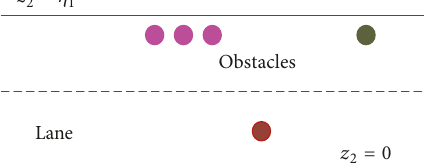
Figure 5: A schematic representation of the road with